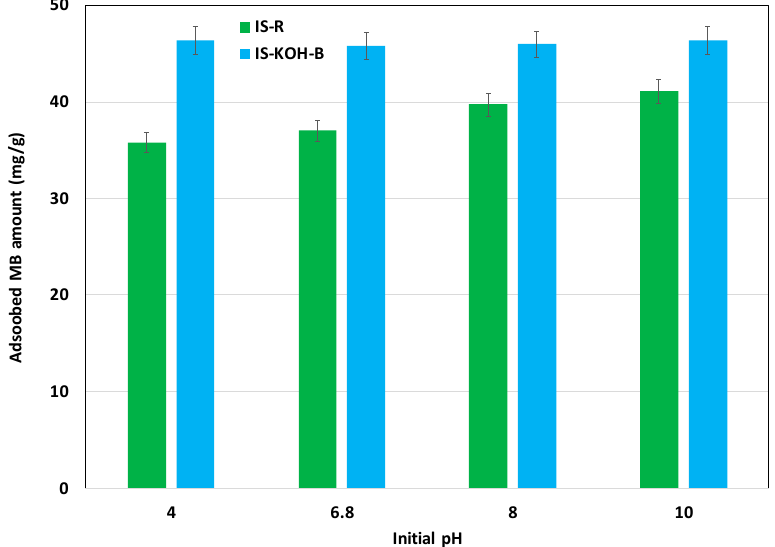
Figure 4. Impact of the aqueous pH on MB removal efficiencies (C0 = 50 mg L − 1 ; D = 1 g L − 1 ; t = 3 h).